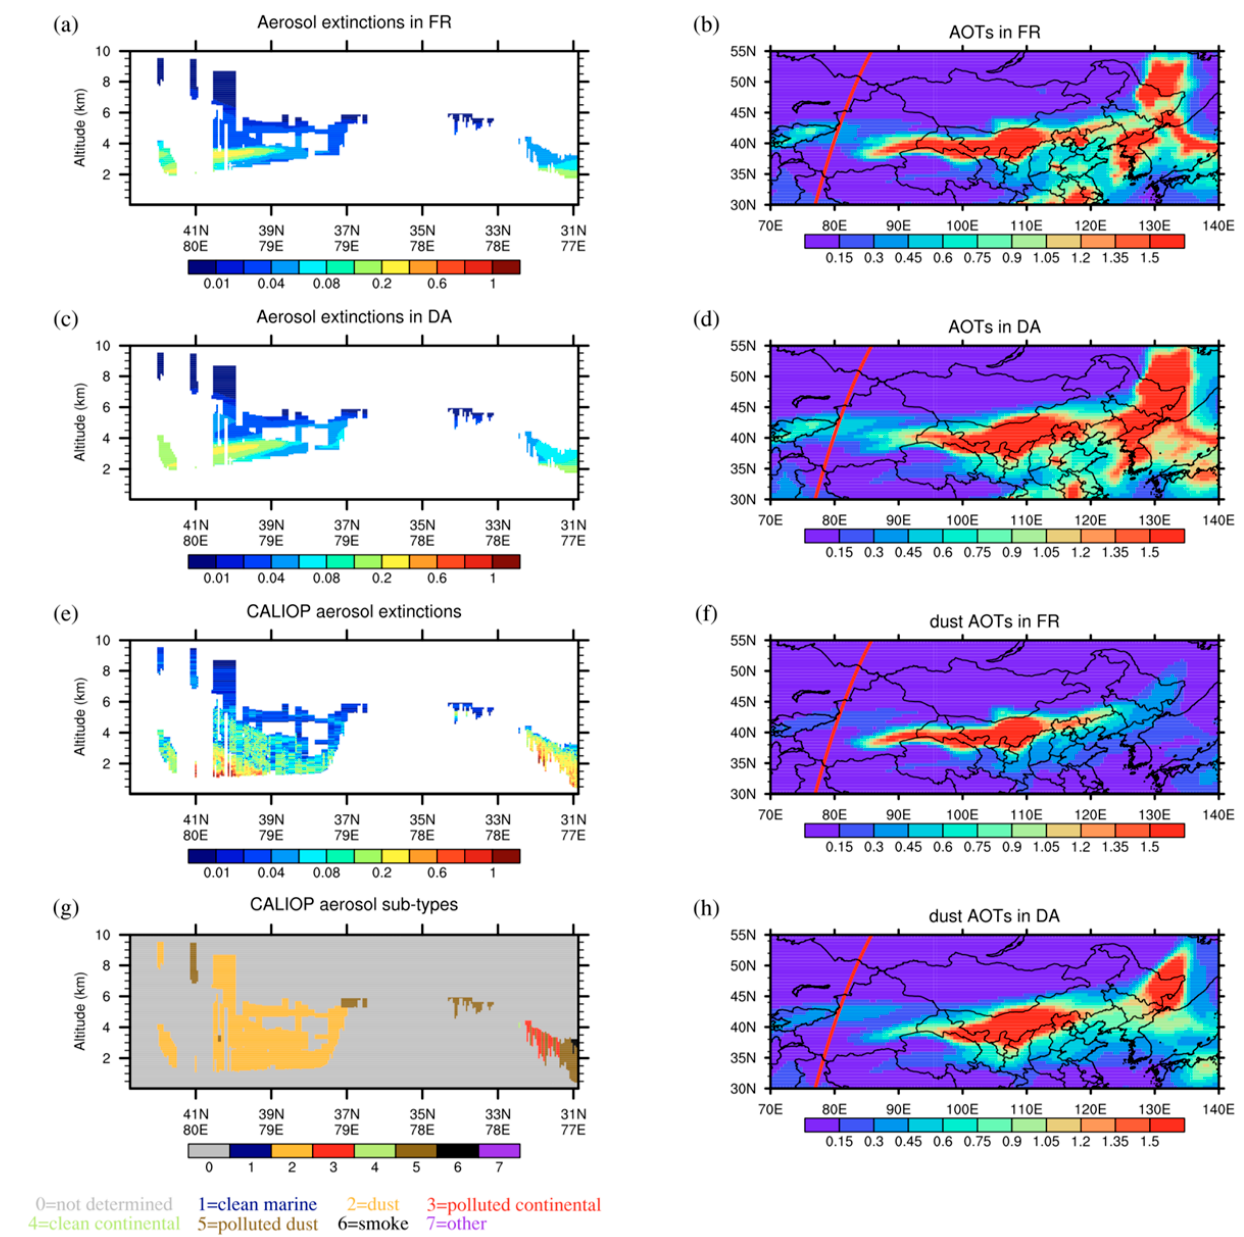
Figure 10. Profiles of simulated aerosol extinction coefficients at 550 nm (km − 1 ) in ( a ) FR and ( c ) DA experiments and CALIOP-observed ones at ( e ) 532 nm over the CALIPSO orbit path (indicated by red curve) at 20:44:02 (UTC) on 1 April 2018. Spatial distributions of ( b , d ) simulated total AOTs and ( f , h ) dust AOTs for the two experiments. ( g ) CALIPSO-detected vertical aerosol sub-types.